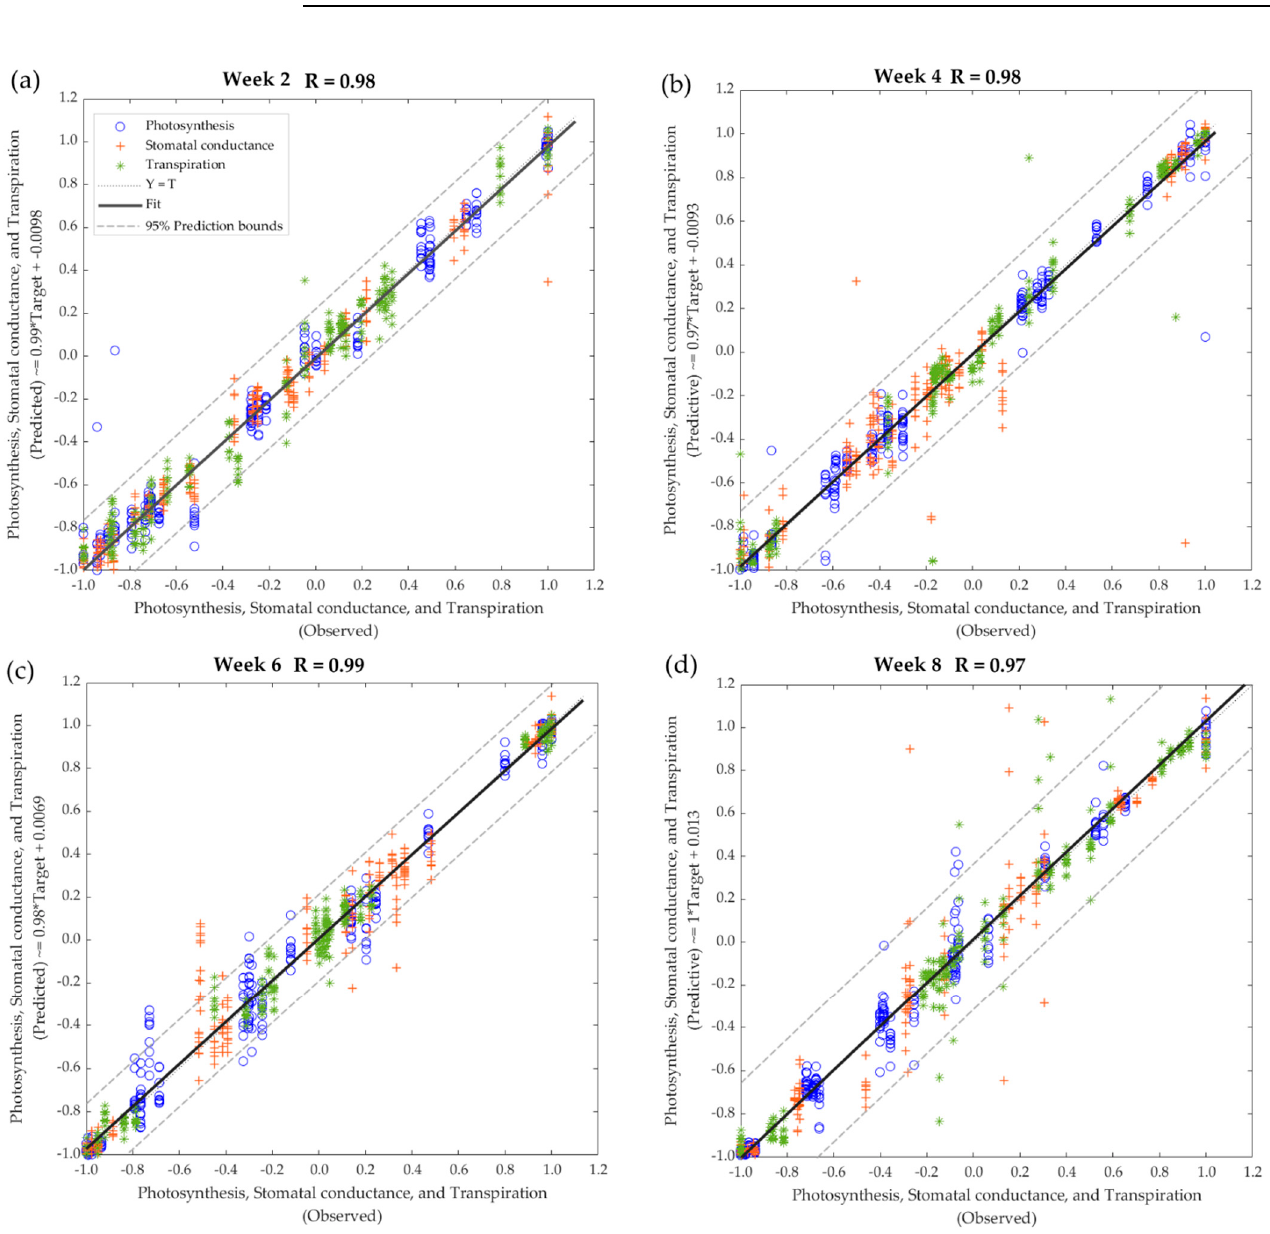
Figure 6. Overall regression models for the glasshouse pathogenicity bioassay of the processing tomato plants to predict plant physiological data using the electronic nose outputs as inputs for general data using all treatments at ( a ) week 2, ( b ) week 4, ( c ) week 6, and ( d ) week 8. Abbreviations: R: correlation coefficient; T: